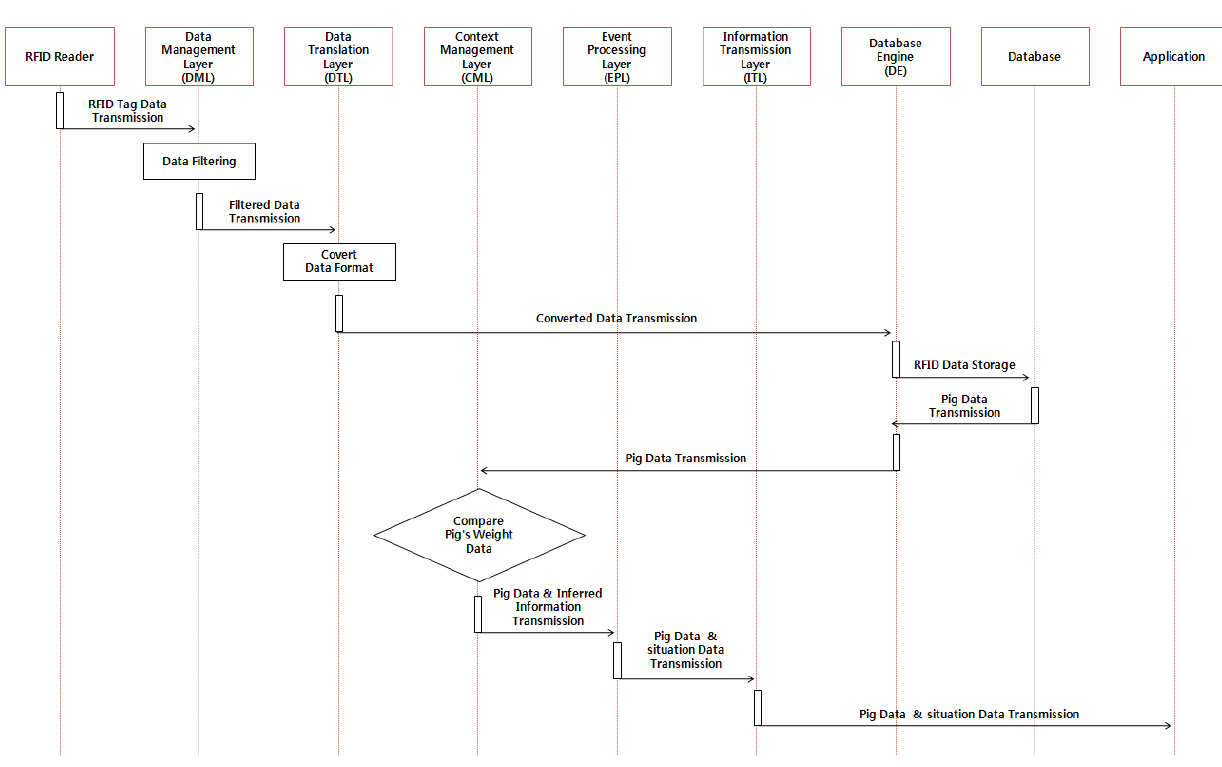
Figure 7. Operation Process of Pig Traceability